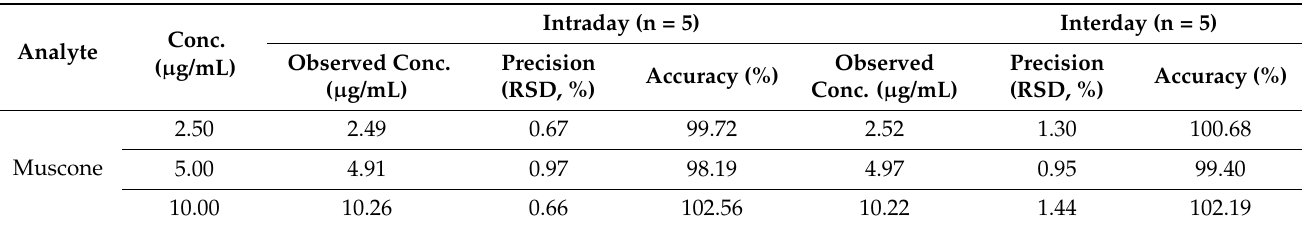
Table 9. Verification of intra- and interday precision for muscone using the GC–MS/MS method (n = 5).